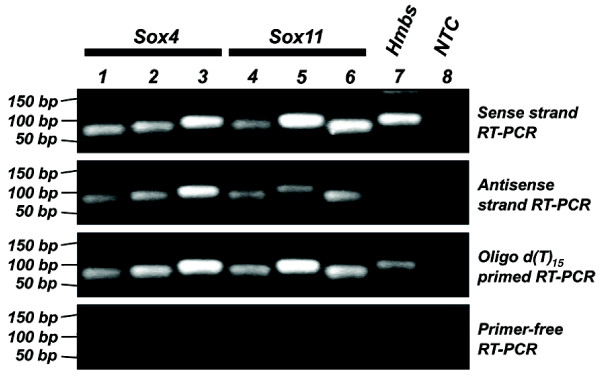
Strand-specific RT-PCR. Lanes 1 to 6 represent the amplification of the Sox4 and Sox11 transcripts using more than one probe. Lane 7 shows the amplification of the Hmbs housekeeping gene whereas lane 8 represents the amplification of water as non-template control (NTC) using the primer set for Hmbs. The first panel consists of amplicons generated from the reverse-transcribed sense strand cDNA whereas the second panel consists of amplicons generated from the reverse-transcribed antisense strand cDNA. The third panel represents amplicons generated from oligo-d [T]15 primed reverse-transcribed cDNA, which serves as a positive control. The last panel represents amplicons generated from primer-free reverse-transcription reactions. The numbers on the left indicate the size of the generated bands.